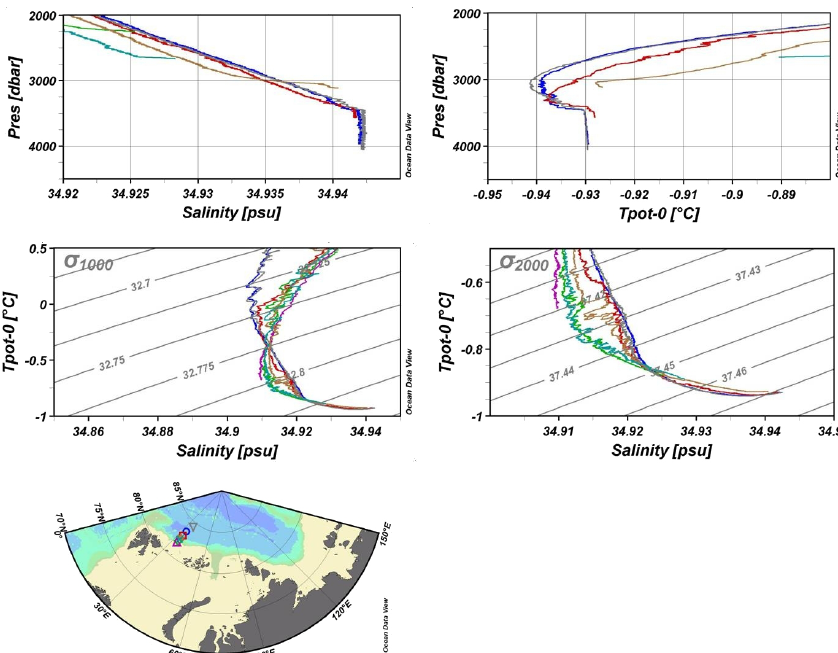
Fig. 17 . Profiles of salinity and potential temperature and θS curves showing the characteristics of the deep and bottom water in the Nansen Basin on the SPACE section along 33 ◦ E and the presence of then deep temperature minimum and the homogenous bottom layer below (profiles) and the less saline deep inflow from the Nordic seas through Fram Strait ( θS